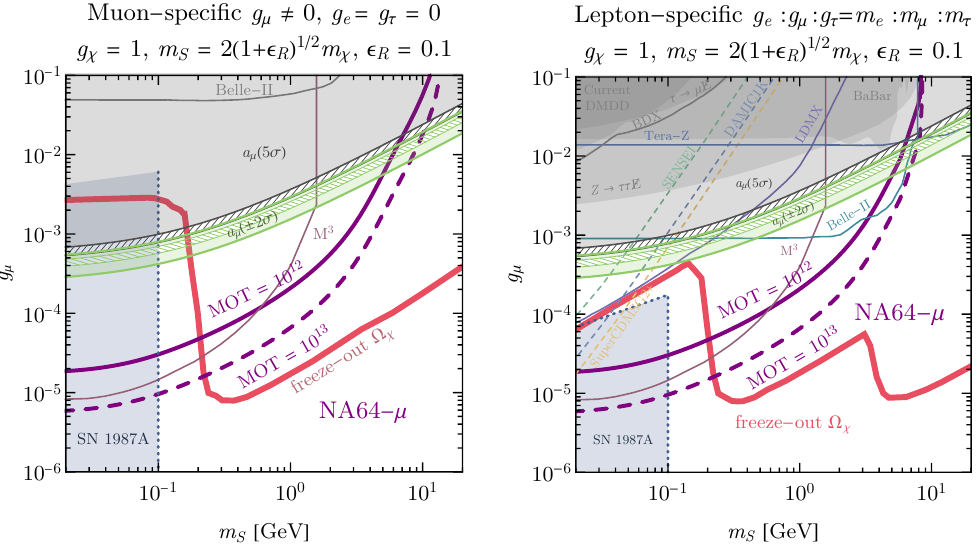
m S Figure 6. As in (cid:12)gure 5 but for m with (cid:15) R = 0 : 1. The proximity of the resonance (cid:31) = 2 p 1+ (cid:15) R allows smaller values of the coupling to saturate the relic abundance while maintaining primarily invisible decays of the mediator across most of the parameter space. Once again, NA64- (cid:22) would be the most sensitive probe of the parameter space